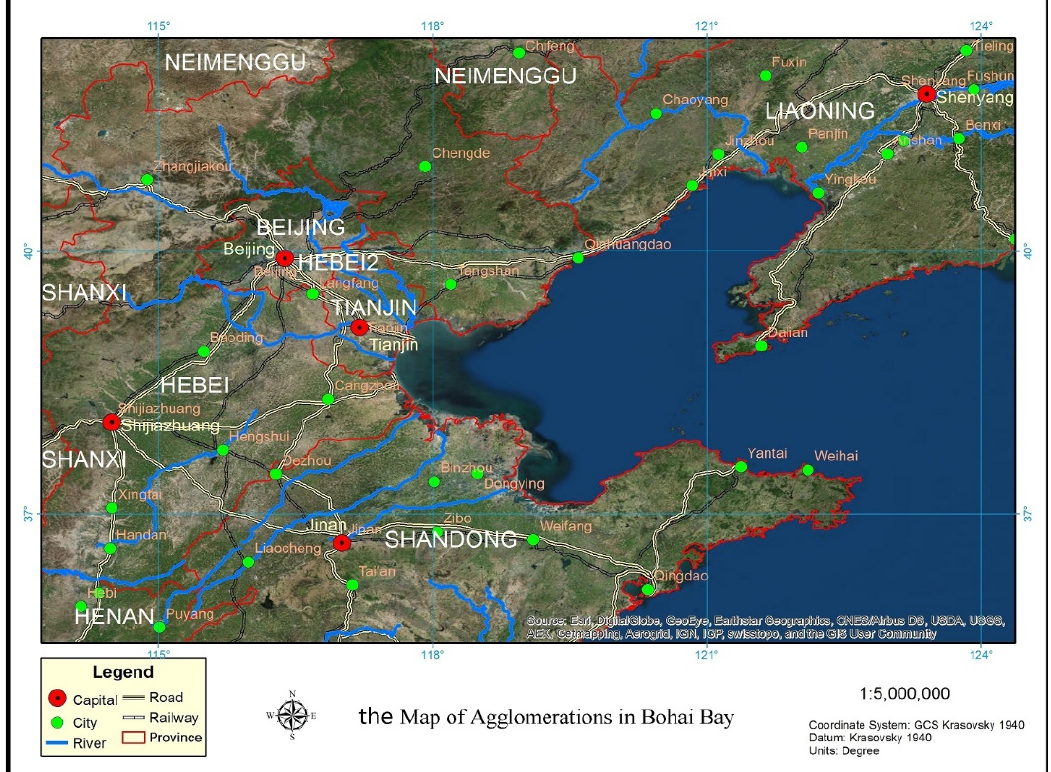
Figure 1. Map of agglomerations in the Bohai Bay city agglomeration.